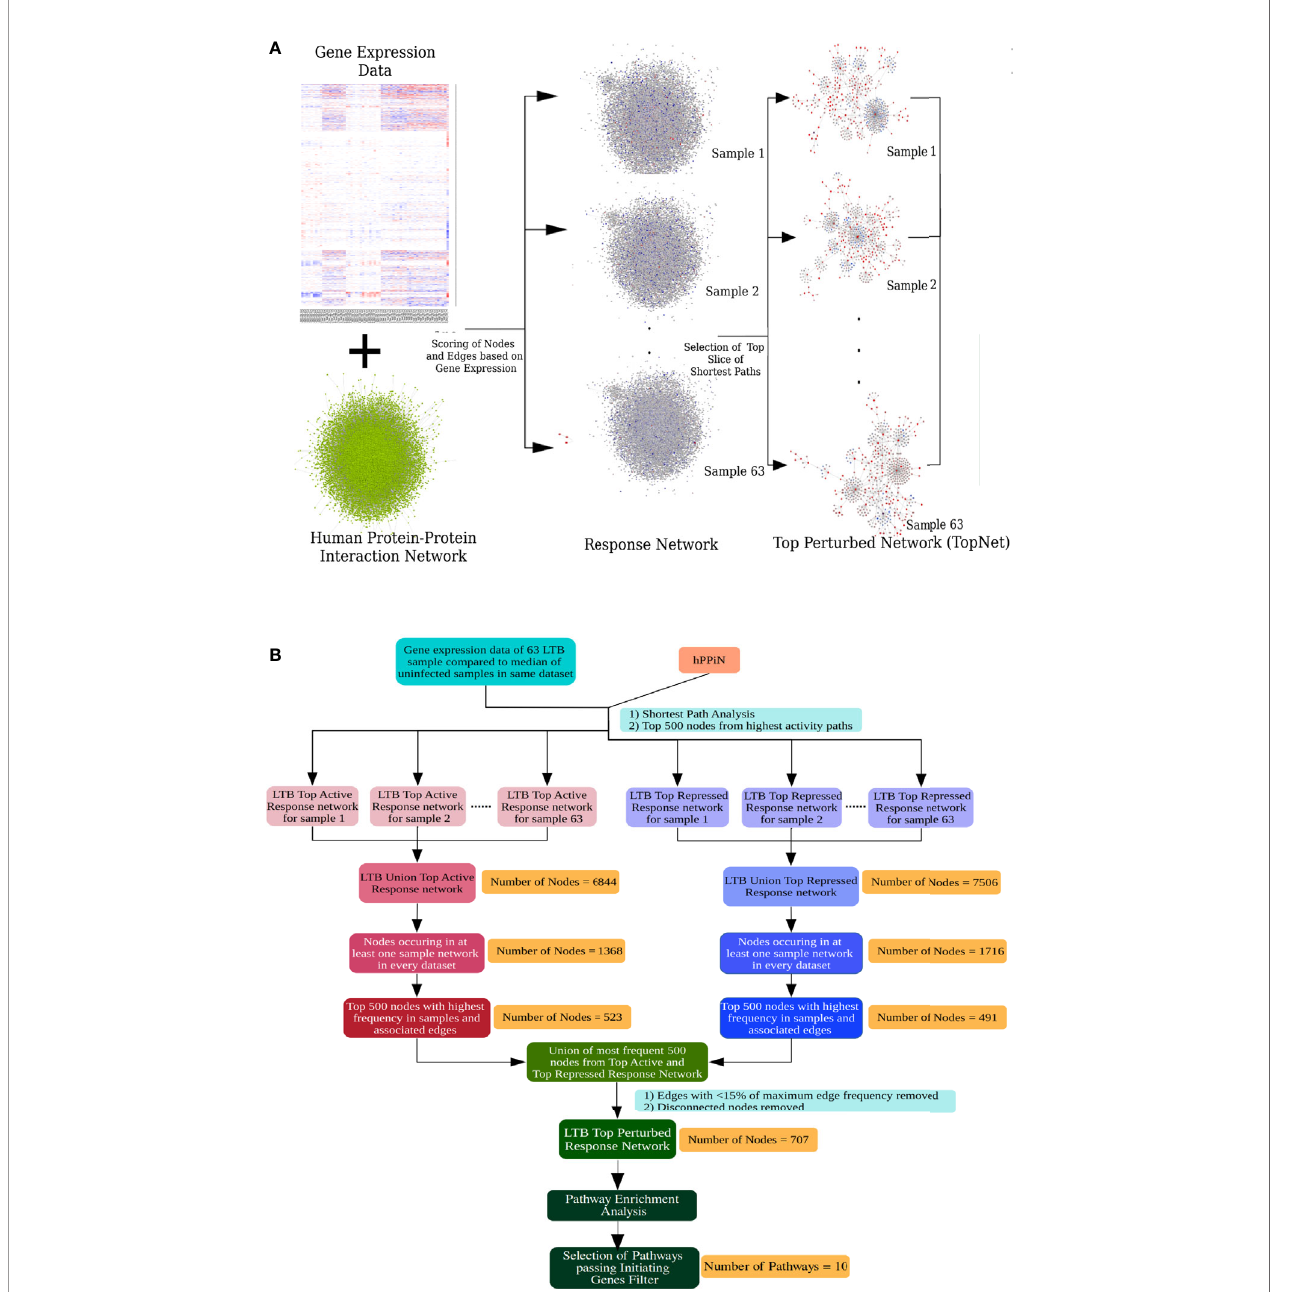
FIGURE 2 | Response network analysis work fl ow. (A) Schematic representation of the individualized protein-protein interaction network analysis work fl ow used in this work. (B) Work fl ow to identify the most frequently perturbed immune response pathways in LTBI